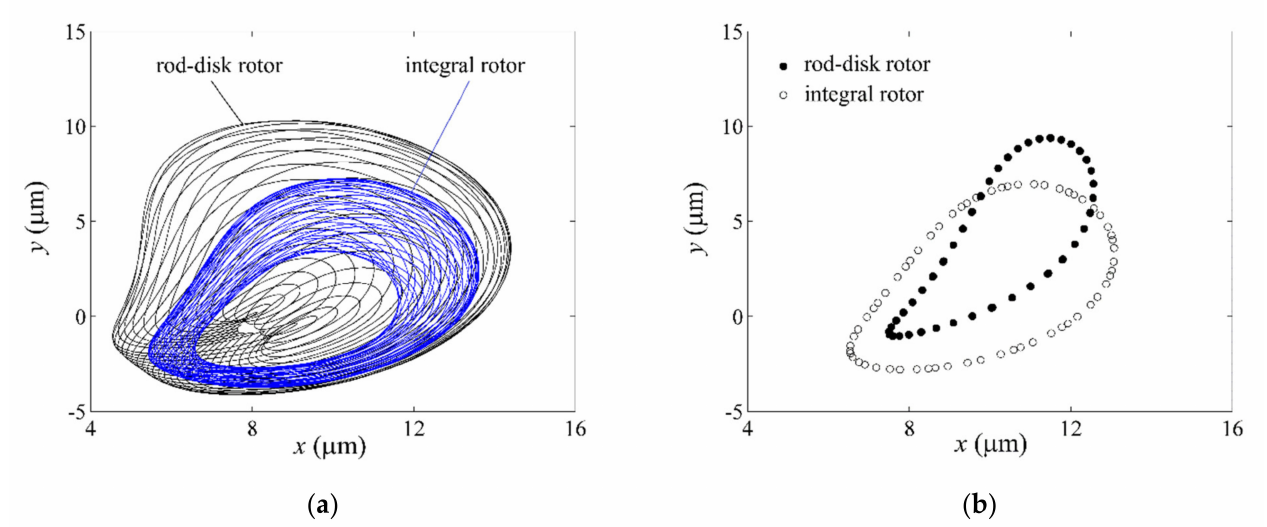
Figure 11. Dynamic orbits and Poincar é map for the flawed rod–disk and integral rotors. ( a ) Dynamic orbits for both rotors; ( b ) Poincar é map for both rotors.